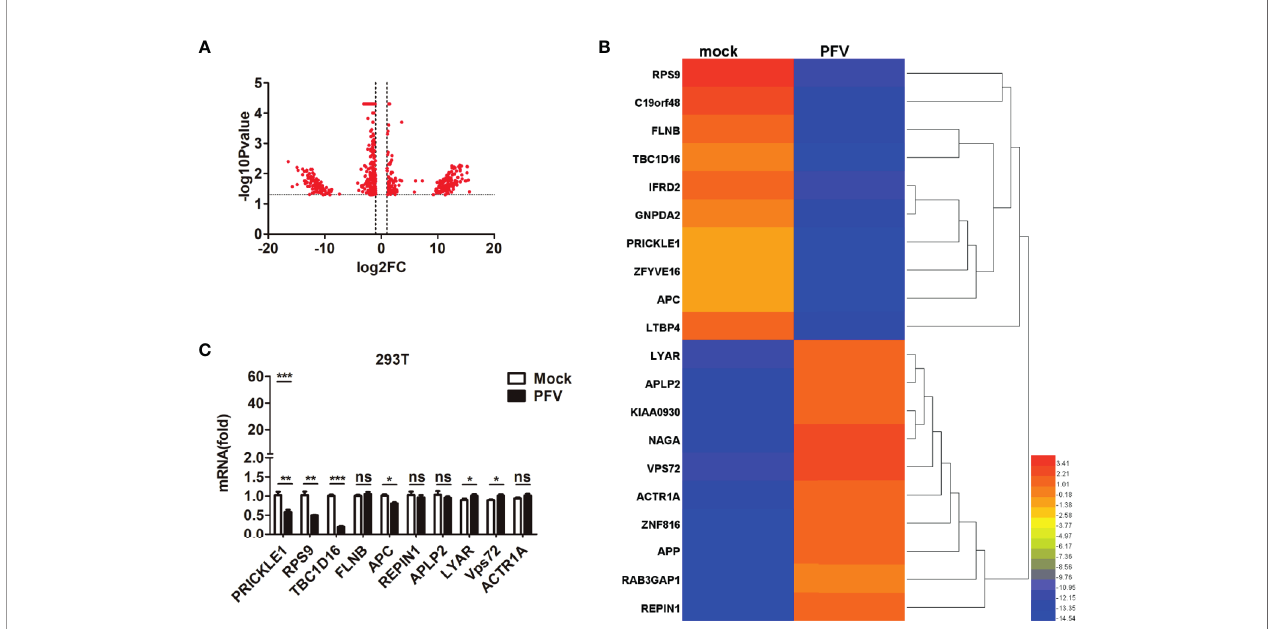
FIGURE 1 | The expressionof TBC1D16 is down-regulatedinPFV-infectedcells. (A) Volcanomapofdifferentiallyexpressedgenes inthehostafter PFVinfection. (B) Heatmap of20 selected geneswiththe most signi fi cant differences inexpression. A scalefrom 3.41to -14.54 representsfolds ofdifferentialexpression. (C) Expressionoftendifferentially expressedgenes encodingfunctionalproteinsinPFV-infectedHEK293Tcellscomparedwithmock-infectedcells (* p <0.05,** p < 0.01, *** p < 0.001 andns, no signi fi